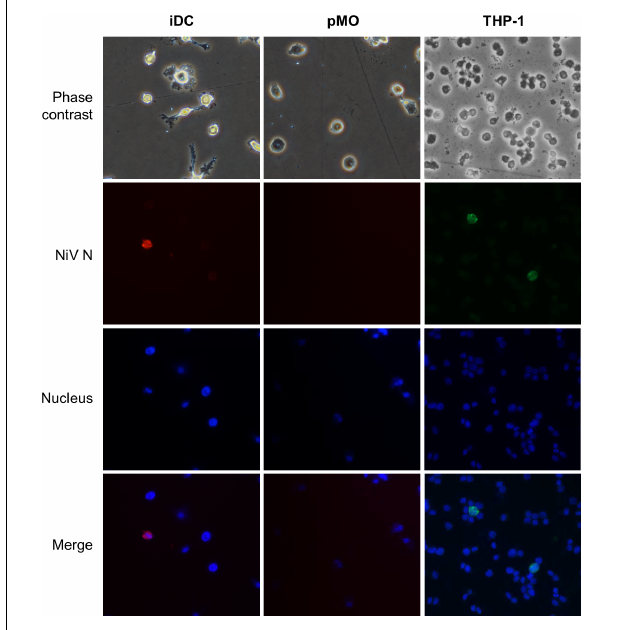
FIGURE 3 | Representative images of phase contrast and immunofluorescence analyses of iDC, pMO and THP-1 infected with NiV at 48 h p.i. The infected cells were stained using polyclonal anti-NiV N with Alexa Fluor R (cid:13) 564-conjugated secondary antibody (red) for iDC and pMO, and Alexa Fluor R (cid:13) 488-conjugated secondary antibody (green) for THP-1. The use of the respective dyes produced less background. Cell nuclei were counterstained with Hoechst 33324 (blue). Magnification at 200 ×